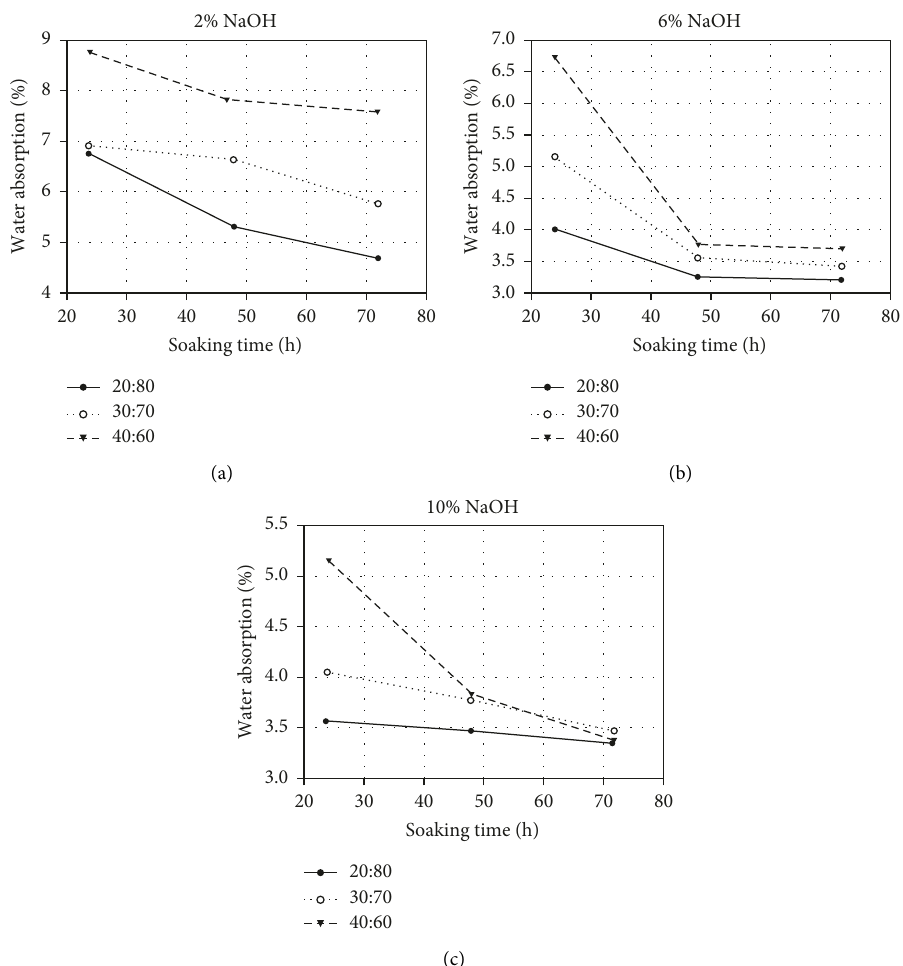
Figure 6: Effect of fiber on polyester ratio for water absorption of composites: (a) 2%, (b) 6%, and (c) 10%